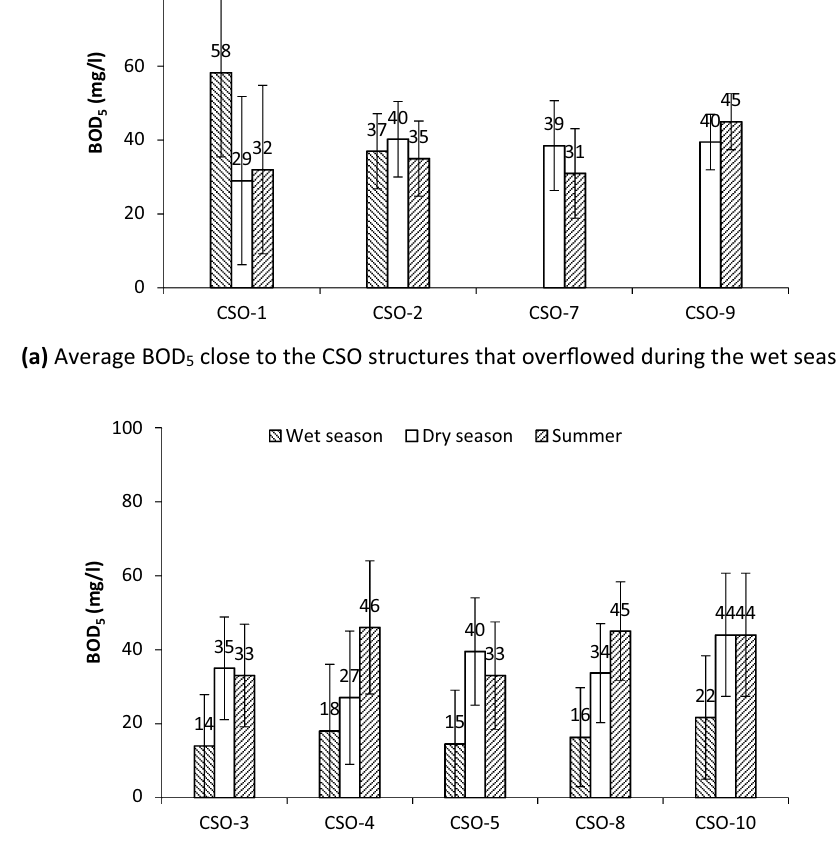
Fig. 3 Average concentra- tions of BOD (mg/l) during 5